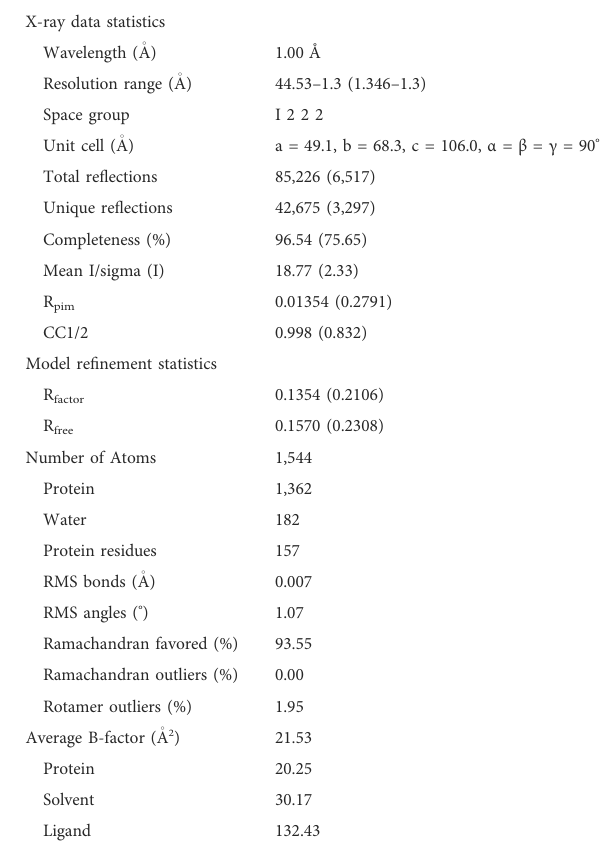
TABLE 2 X-ray data collection and model re fi nement statistics.